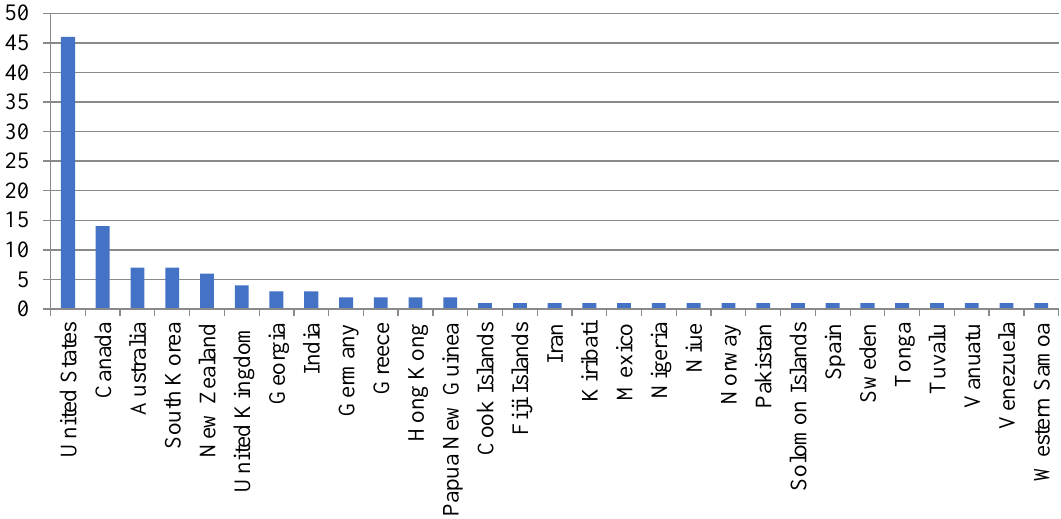
Figure 2. Frequency of the countries covered in the studies.